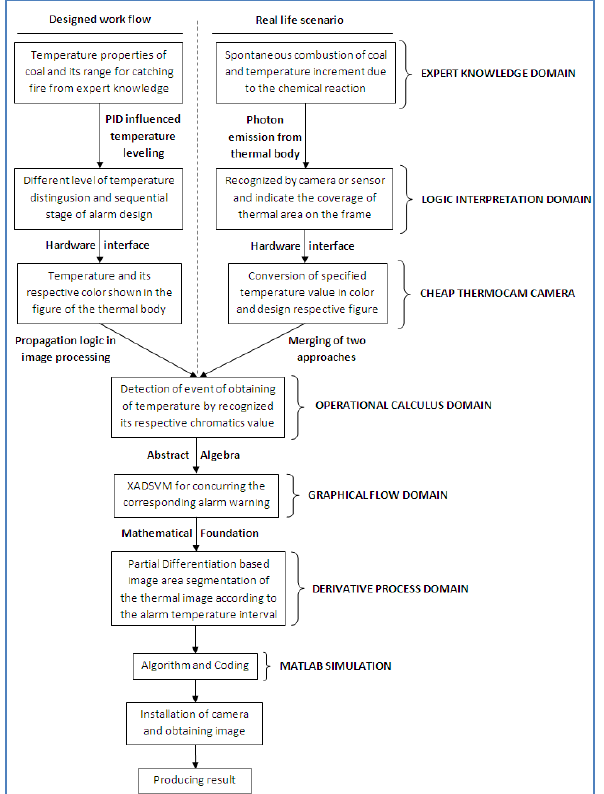
Figure 26. Complete sequence of work of the investigation